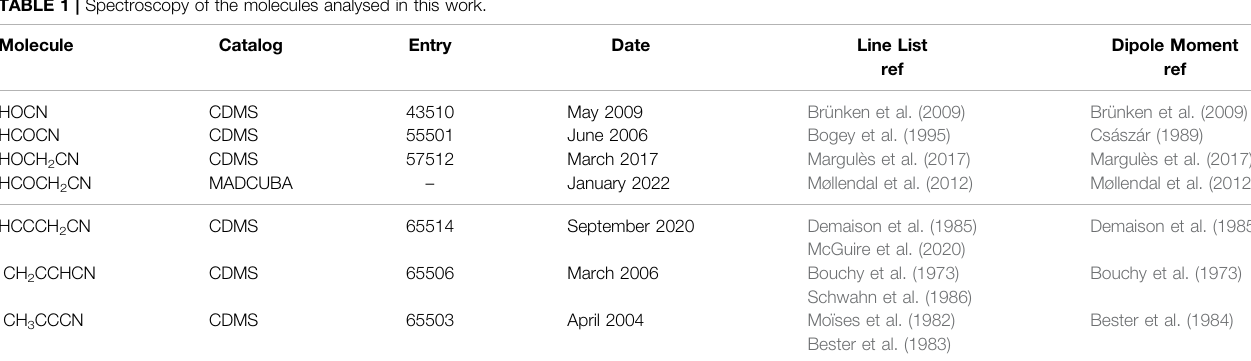
TABLE 1 | Spectroscopy of the molecules analysed in this